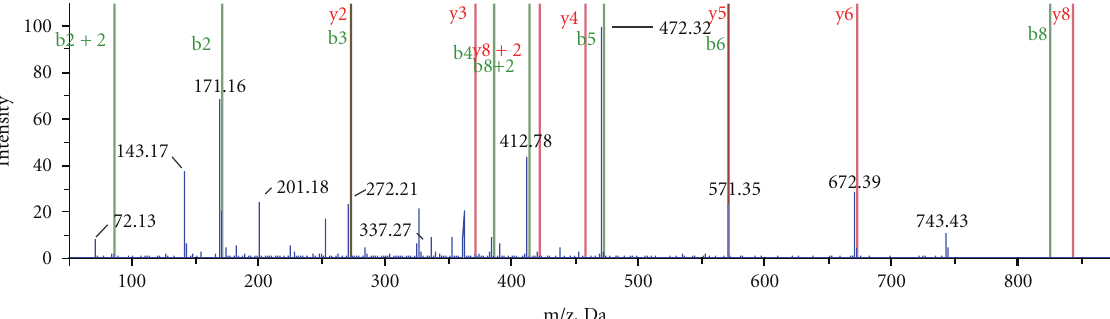
Figure 2: T cell receptor alpha spectra: T-cell receptor alpha was detected in the leukocytes of estrogen receptor-positive breast cancer not in that of estrogen receptor negative. LC-Q-TOF MS/MS spectra of GITLSVRP peptide generated from the trypsin digestion of TCR- α .